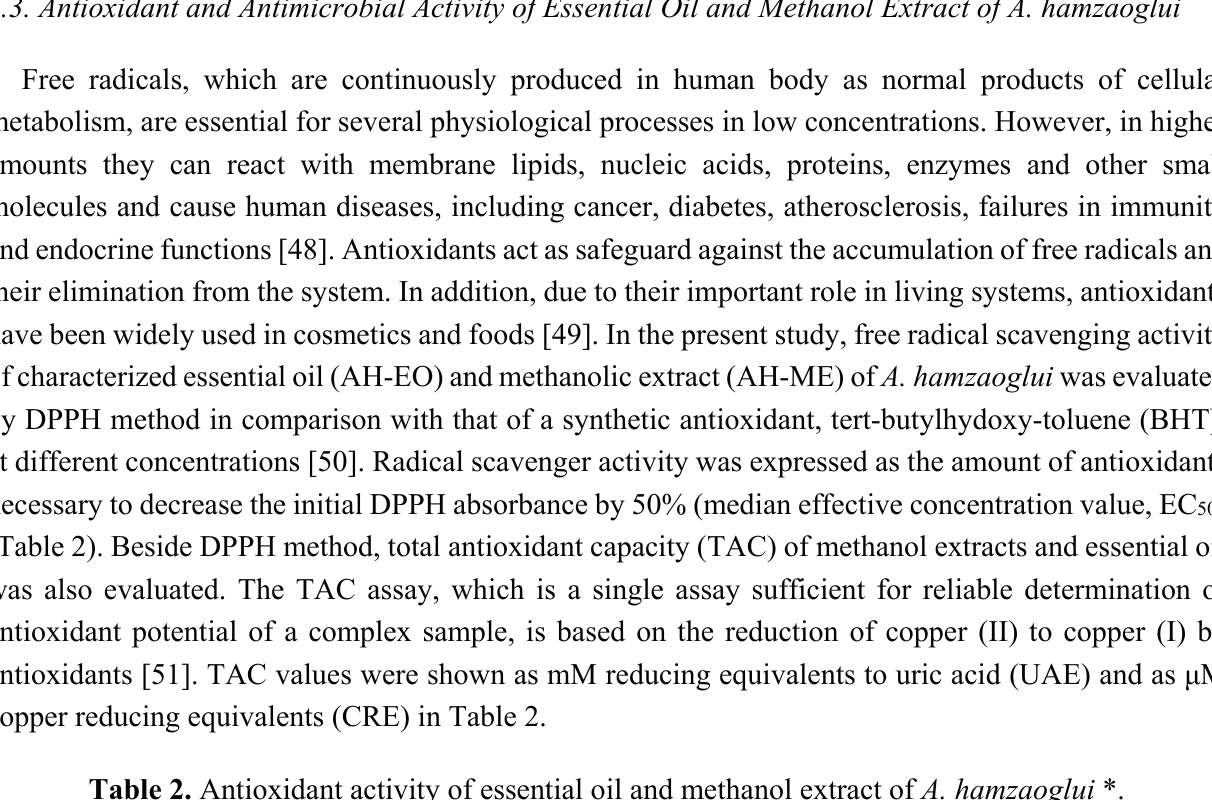
Table 2. Antioxidant activity of essential oil and methanol extract of A. hamzaoglui *.